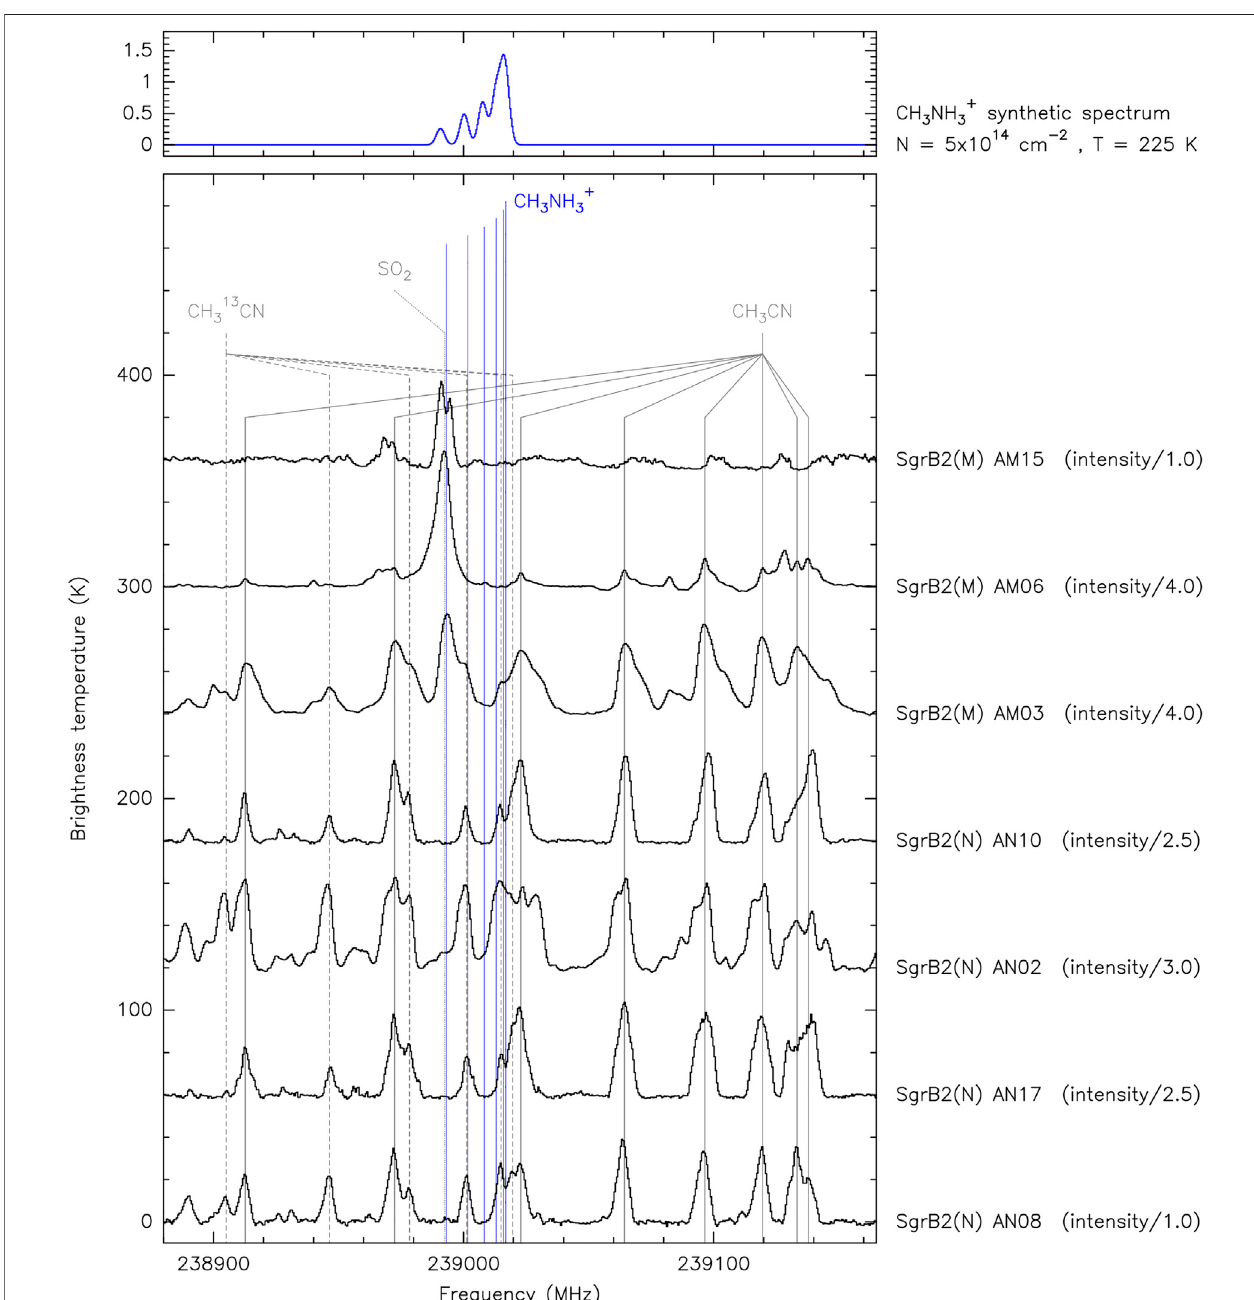
FIGURE 4 | ALMA spectra towards seven dense cores in the SgrB2(N) and (M) regions. Data from Sánchez-Monge et al. (2017). The baseline for each spectrum corresponds to a brightness temperature of 0 K, however, the spectrum of each source has been manually shifted by 60 K (with respect to the source below) for an easier visualization of the data. The intensities of some spectra have been divided by the factor indicated to the right. Grey solid and dashed vertical lines mark the